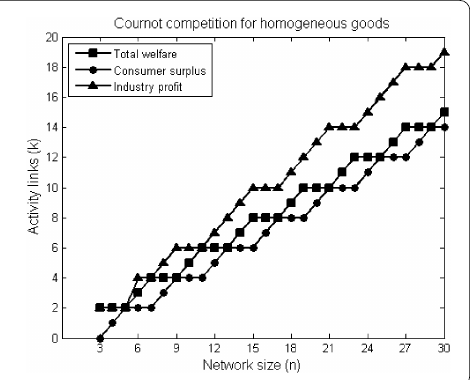
Figure 7 The maximum total welfare, consumer surplus and industry profit for different sizes of symmetric networks 3 ≤ n ≤ 30. The parameters used to plot the figures are a = 2, c = 1 and γ =